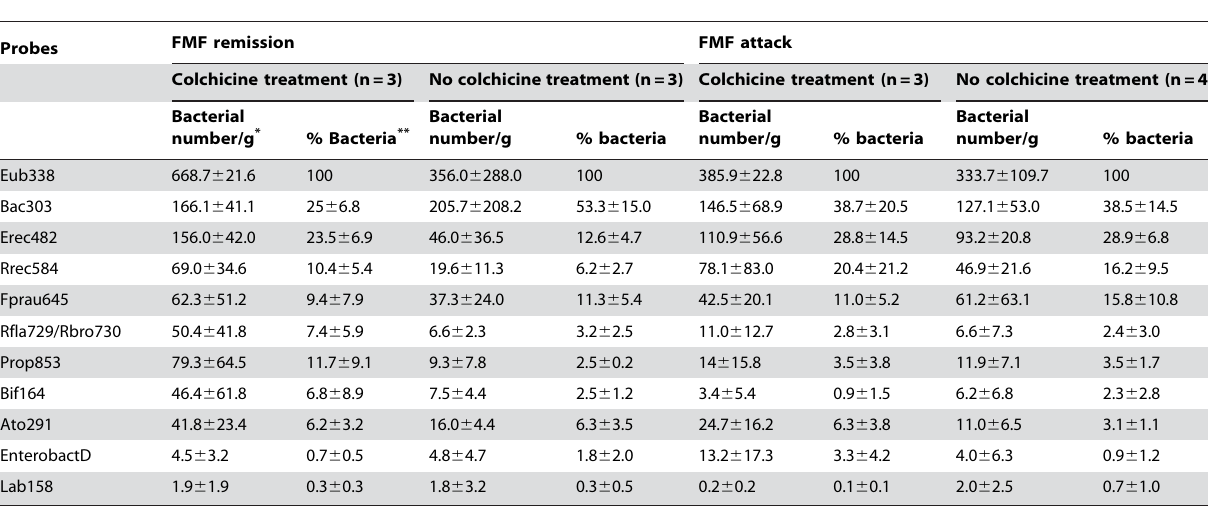
Mean count 6 SD. * Counts 10 8 cells per gram of fecal specimen. ** The percentage relative to the total number of cells determined by Eub338. doi:10.1371/journal.pone.0003064.t007 PLoS ONE |